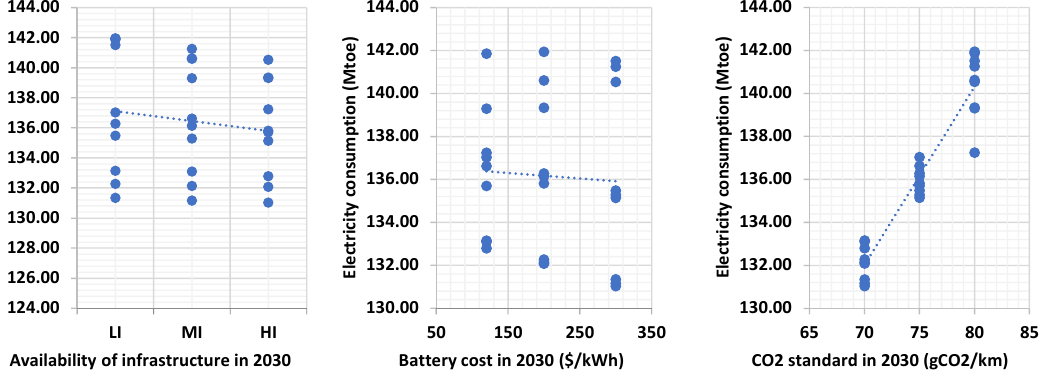
Figure 7. The distribution of final energy consumption of cars in the EU in 2030. Table 8. The results of multiple regression for total final energy consumption by cars in the EU in 2030. Coe ffi